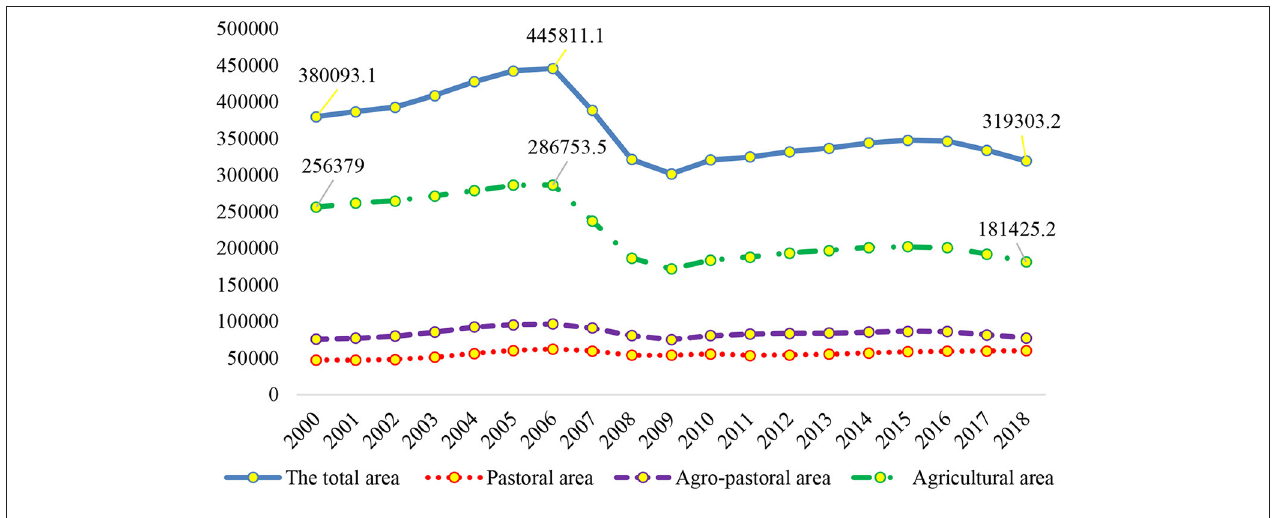
FIGURE 2 | Calculated results of carbon emissions of animal husbandry from 2000 to 2018 (unit: thousand